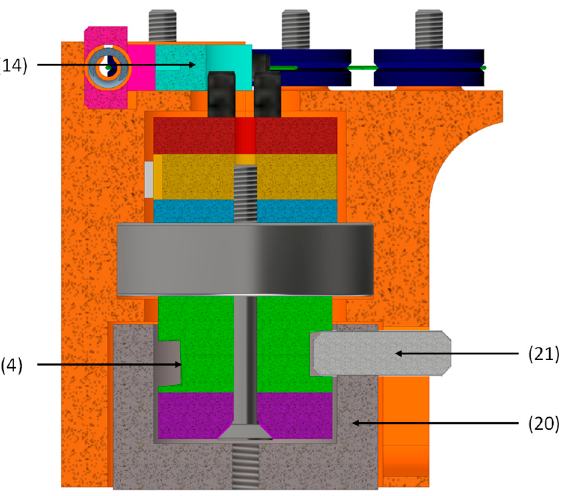
Figure 4. Unrolled height profile of the circumferential groove of the shaft.